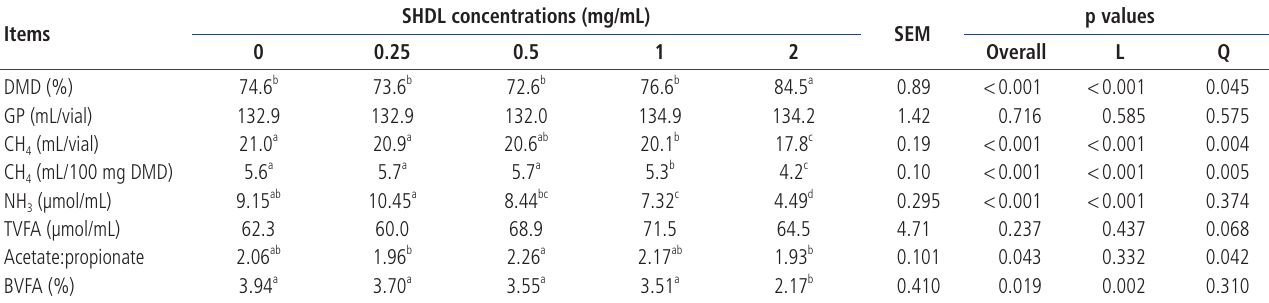
Table 2. Effects of sodium hydroxide dehydrated lignin (SHDL) at 0, 0.25, 0.5, 1.0, and 2.0 mg/mL on ruminal fermentation of barley grain after 24-h in vitro incubation